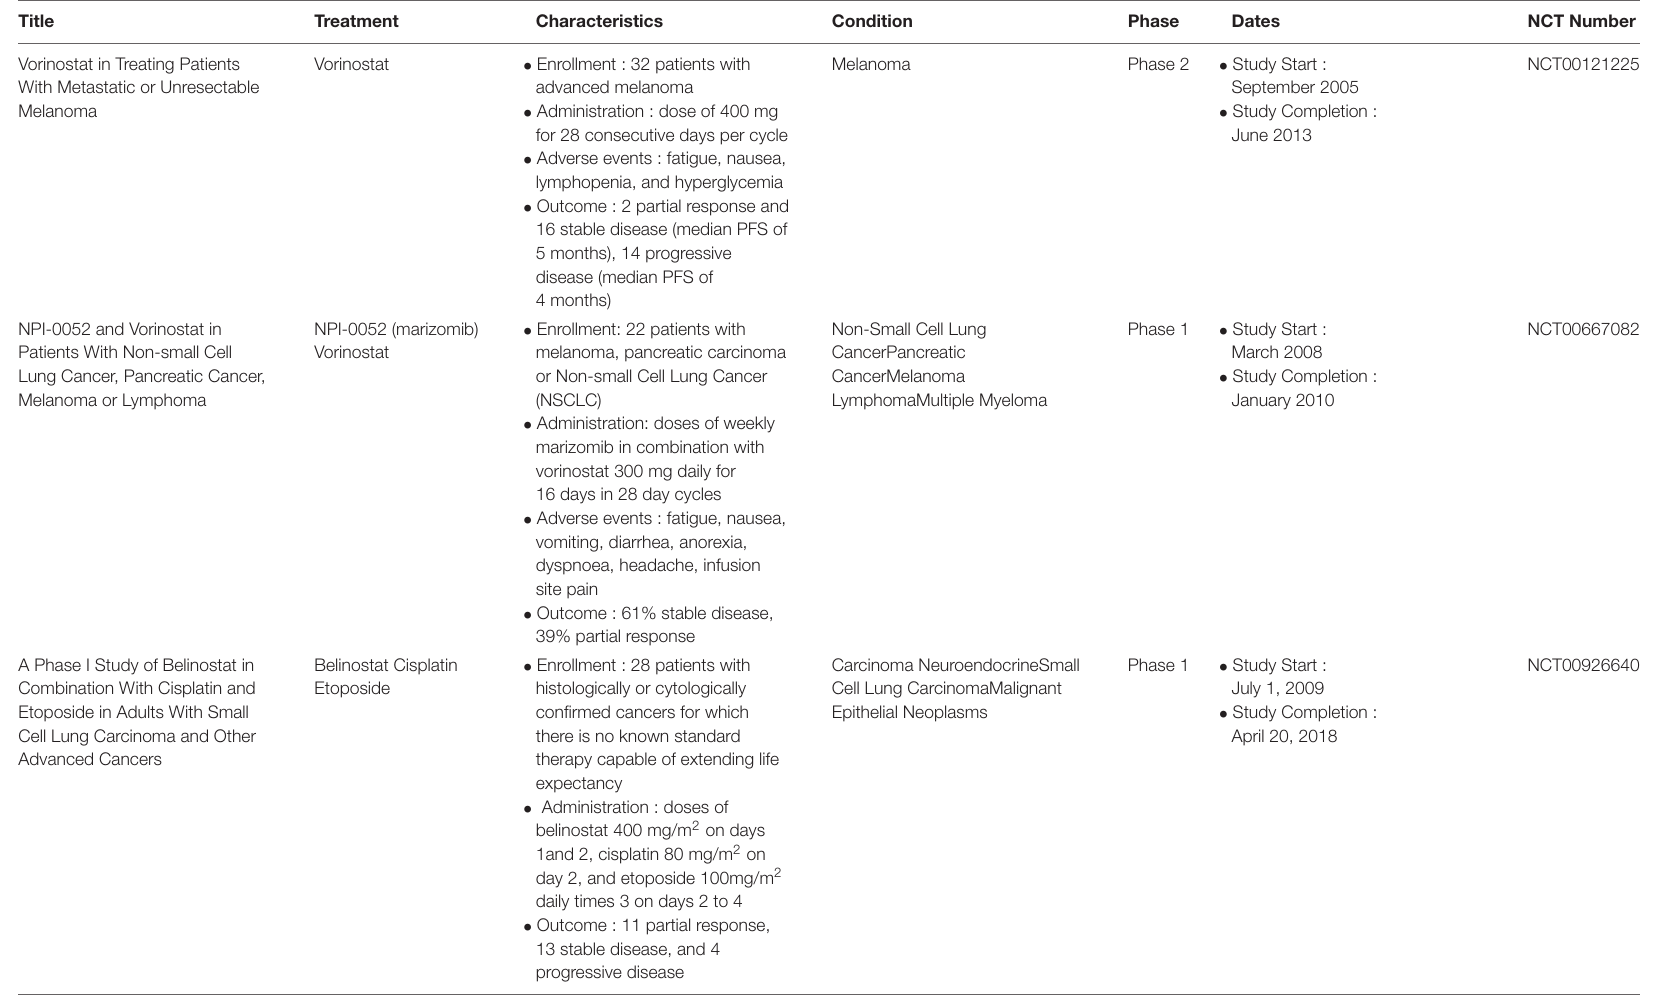
TABLE 2 | Clinical trials of HDAC inhibitors: characteristics of clinical trials registered in